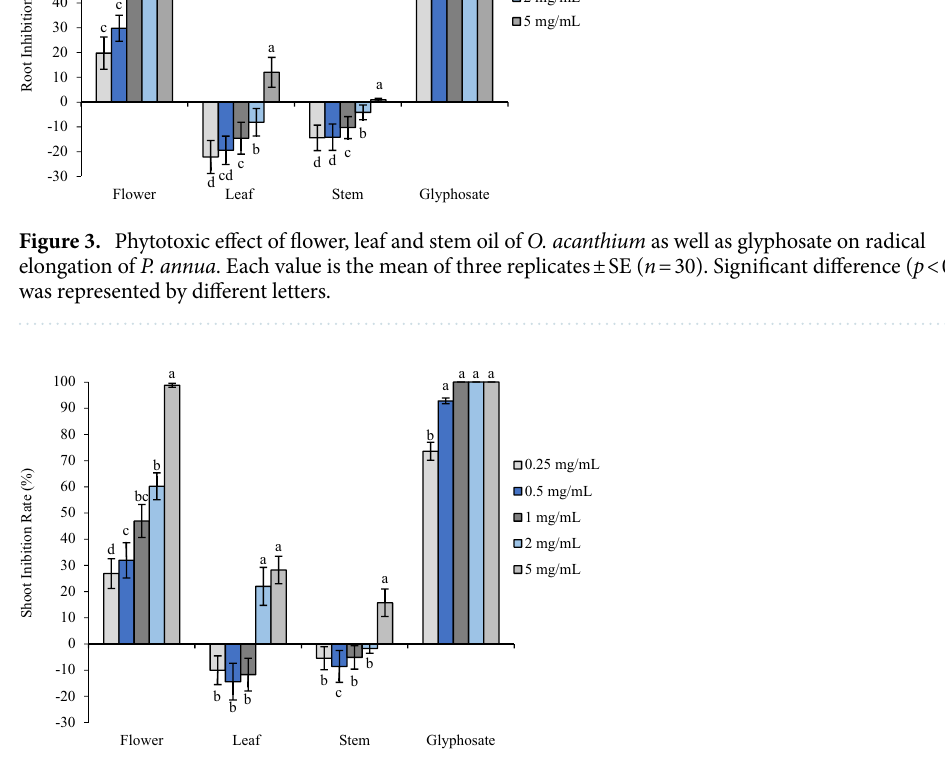
Figure 4. Phytotoxic effect of flower, leaf and stem oil of O. acanthium as well as glyphosate on shoot elongation of P. annua . Each value is the mean of three replicates ± SE ( n = 30). Significant difference ( p < 0.05) was represented by different